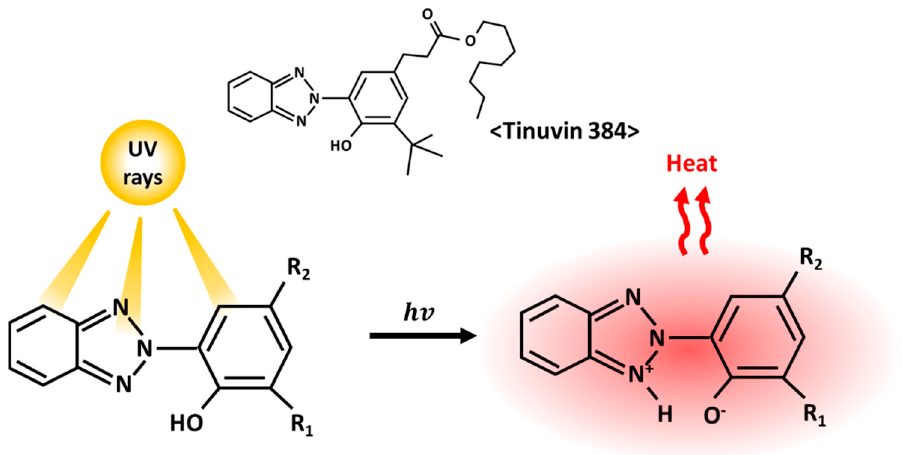
Figure 7. Mechanism of Tinuvin UV absorber